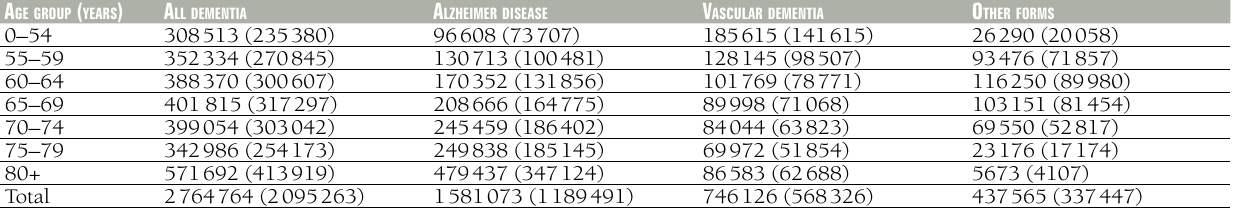
Table 8 The estimates of the total number of cases of dementia, Alzheimer disease, vascular dementia and other forms of dementia in Africa in the year 2010 (figures in brackets: Sub–Saharan Africa